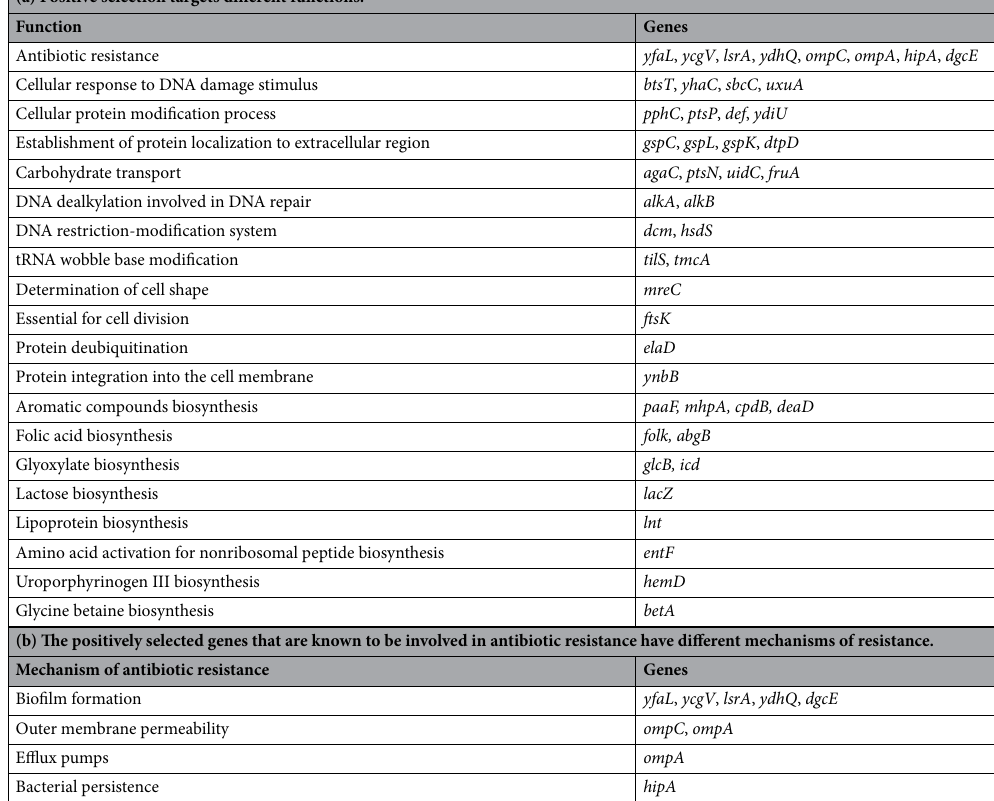
Table 1. Targets of positive selection. (a) Generally. (b) With respect to antibiotic resistance.